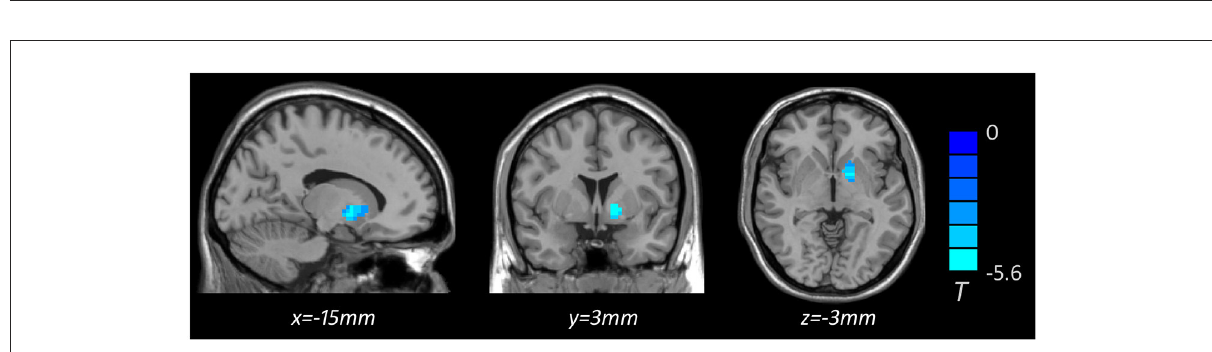
FIGURE2 Brain region showing significant structural difference between MDD with anhedonia and HCs ( p < 0.05, GRF corrected ). The color scale represents t values.